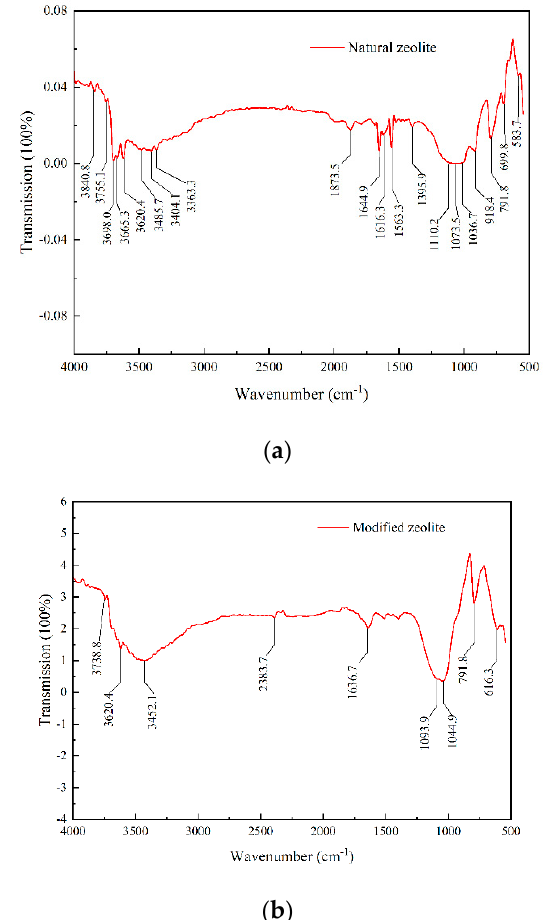
Figure 6. FTIR analyses of zeolites: ( a ) natural zeolite, ( b ) modified zeolite.